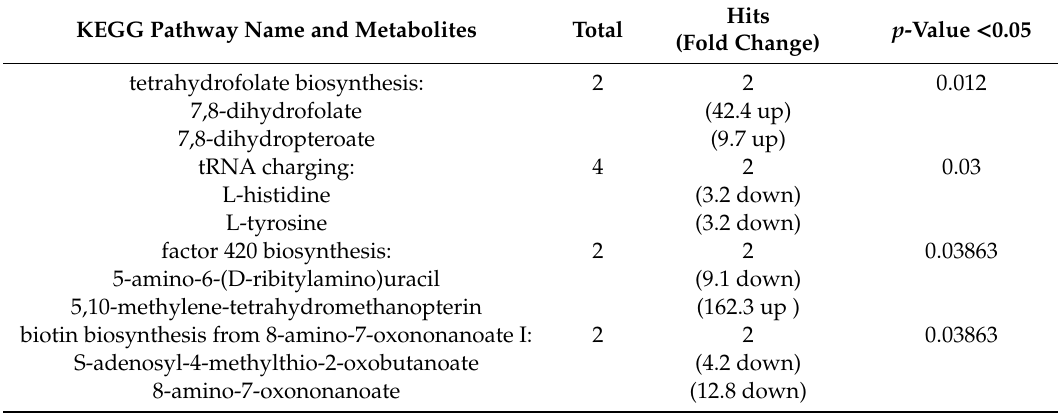
Table 1. Activity network (connections) obtained for bacteria under the treatment of cinnamaldehyde. KEGG Pathway Name and